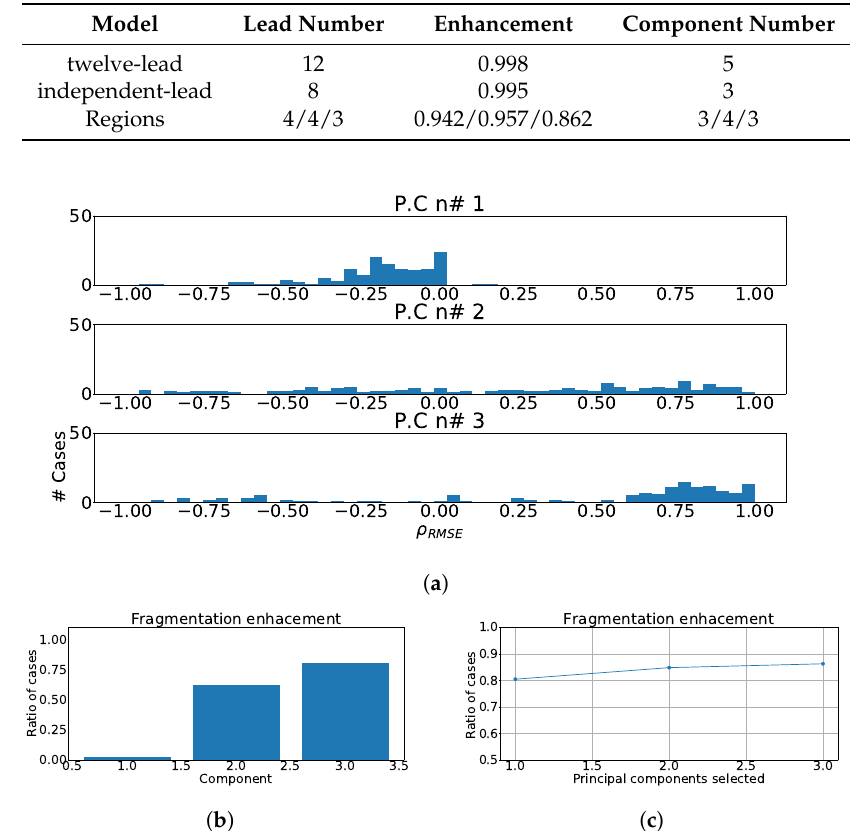
Figure 9. Different measurements for PCA over inferior heart region. ( a ) Distribution of ρ RMSE coefficient for each independent component, values lower than zero represents cases where the RMSE measured over the ECG is greater than RMSE measured over the independent component. ( b ) Ratio of fragmentation wave enhancement for each independent component, this ratio is computed as cases where the ρ RMSE value is greater than zero. ( c ) Cumulative ratio of fragmentation wave enhancement, this ratio is computed by joining the results of isolated independent